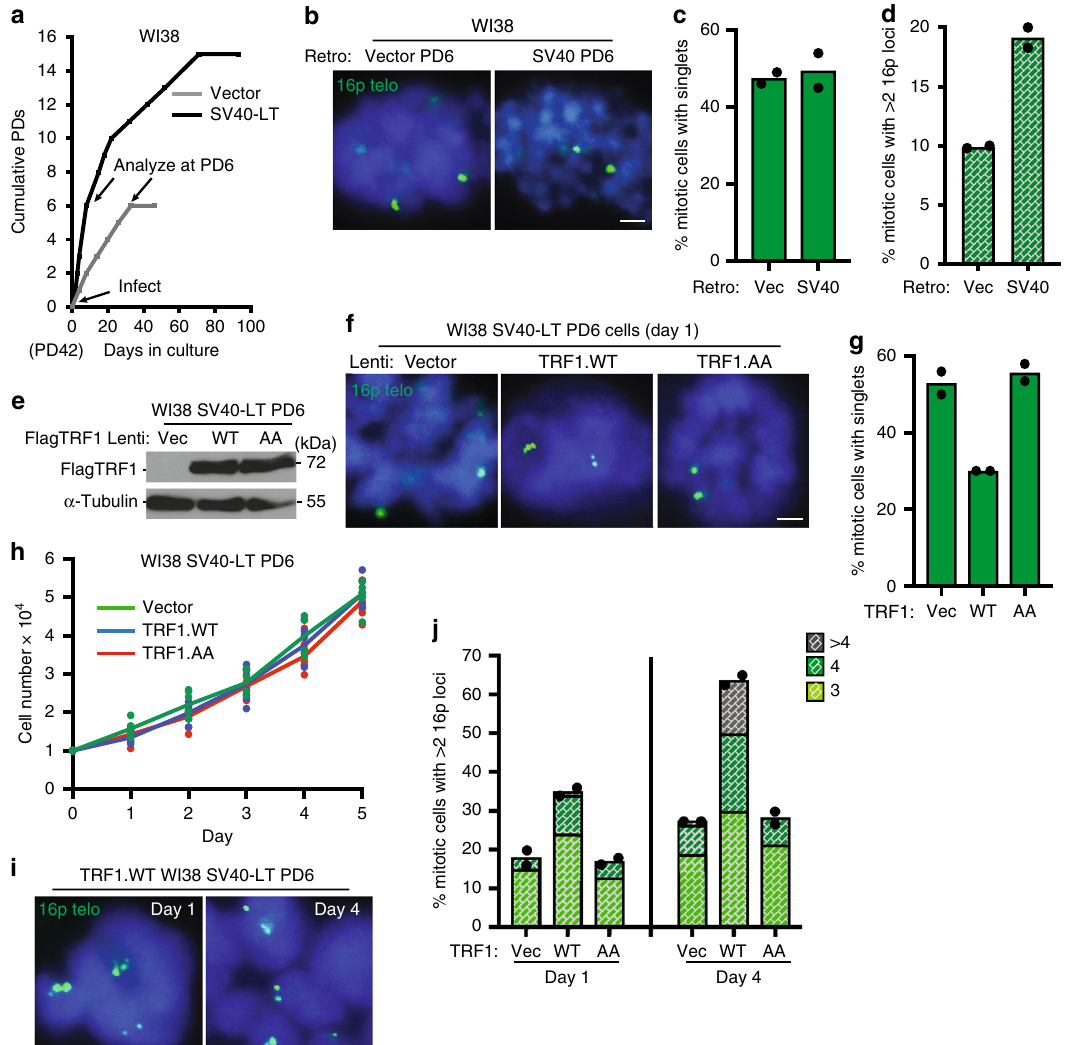
Fig. 4 Loss of the DNA damage checkpoint leads to runaway subtelomere recombination. a Growth curve analysis of Vector or SV40-LT infected mid (PD42) WI38 cells. Subsequent analyses were performed at PD6 (indicated) when Vector-infected cells begin to senesce. b FISH analysis of Vector or SV40-LT infected WI38 mitotic cells at PD6 using a 16p telo probe (green). Quanti fi cation of the frequency of mitotic cells ( c ) with cohered telomeres or ( d ) exhibiting subtelomere copying in Vector or SV40-LT-infected WI38 cells at PD6. Average of two independent experiments ( n ≥ 41 cells each). e Immunoblot analysis of Vector, TRF1.WT, or TRF1.AA infected WI38 SV40-LT (PD6) cell extracts. f FISH analysis of Vector, TRF1.WT, or TRF1.AA infected WI38 SV40-LT (PD6) cells on Day 1 of growth curve analysis using a 16p telo probe (green). g Quanti fi cation of the frequency of mitotic cells with cohered telomeres. Average of two independent experiments ( n ≥ 43 cells each). h Growth curves of Vector, TRF1.WT, or TRF1.AA WI38 infected SV40- LT (PD6) cells. Three technical replicates from two independent experiments each. i FISH analysis of TRF1.WT infected WI38 SV40-LT (PD6) mitotic cells exhibiting subtelomere copying on Day 1 and Day 4 of growth curve analysis using a 16p telo probe (green). j Quanti fi cation of the frequency of mitotic cells exhibiting subtelomere copying. Average of two independent experiments ( n ≥ 40 cells each). b , f , i DNA was stained with DAPI (blue). Scale bars represent 2 μ m. Experiments were repeated independently twice (for a , b , e , f , i ) with similar results. Source data are provided as a Source Data fi same time suppressed subtelomere recombination between the resolved and extended telomeres. For the second approach, we introduced Vector, TRF1.WT, or TRF1.AA into BIBR-treated HTC75 cells at PD245 by transient transfection (Supplementary Fig. 5e). TRF1.WT, but not Vector or TRF1.AA, forced resolution of telomere cohesion (Fig. 6m, n), similar to removal of BIBR. However, unlike removal of BIBR, TRF1.WT over- expression induced subtelomere recombination (Fig. 6o, p). Introduction of the same alleles into BIBR-treated HTC75 cells at PD245 by lentiviral infection (Supplementary Fig. 5f) showed that overexpression of TRF1.WT, but not Vector or TRF1.AA, led to an increase in RAD51 foci (Supplementary Fig. 5g, h) and